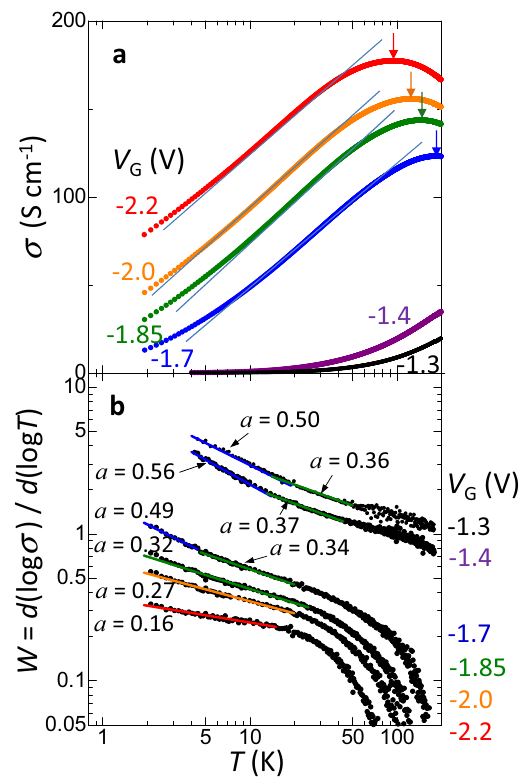
Fig. 2 Temperature and gate voltage dependence of the conductivity. a Semilogarithmic plot of the temperature T dependence of the conductivity σ ( T ) under different gate voltages V G . The arrows indicate the temperatures of the maximum conductivity for each V G . σ ( T ) deviates from ln T dependence at low temperature side. b Zabrodskii plot (a double- logarithmic plot of W = d (log σ )/ d (log T ) vs. T ) for each V G . The variable- range hopping exponents a obtained by the analysis are indicated besides each